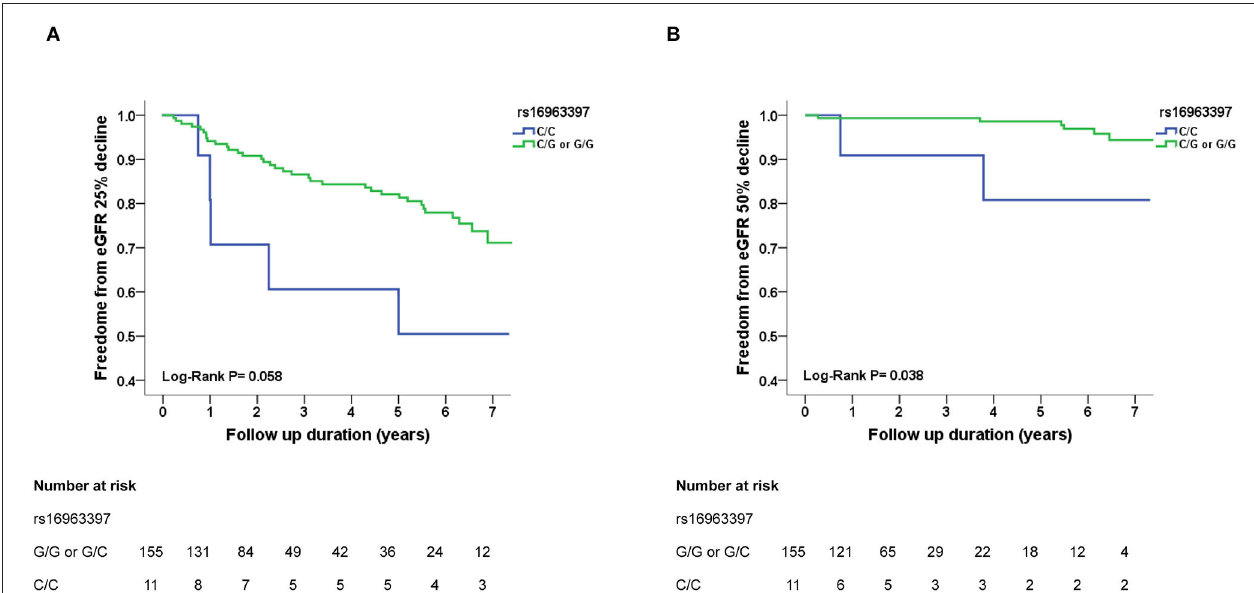
FIGURE 2 | Kaplan–Meier survival curves showing the absence of renal events with respect to SLC12A3 rs16963397 polymorphisms in patients with hypertension in cohort 3. All participants were divided into two groups according to SLC12A3 rs16963397 polymorphisms. In panel A and B, the blue line represents the patient group with SLC12A3 rs16963397 C/C polymorphisms, and the green line represents the group with SLC12A3 rs16963397 C/G or G/G polymorphisms. Renal events were defined as > 25% decline and > 50% decline in estimated glomerular filtration rate (eGFR). Differences were compared using the log-rank test. (A) SLC12A3 rs16963397 polymorphisms (C/C vs. C/G or G/G) and > 25% decline in eGFR ( P = 0.058). (B) SLC12A3 rs16963397 polymorphisms (C/C vs. C/G or G/G) and > 50% decline in eGFR ( P = 0.038). The findings of SLC12A3 rs16963397 C/C and SLC12A3 rs13334864 C/C polymorphisms were the